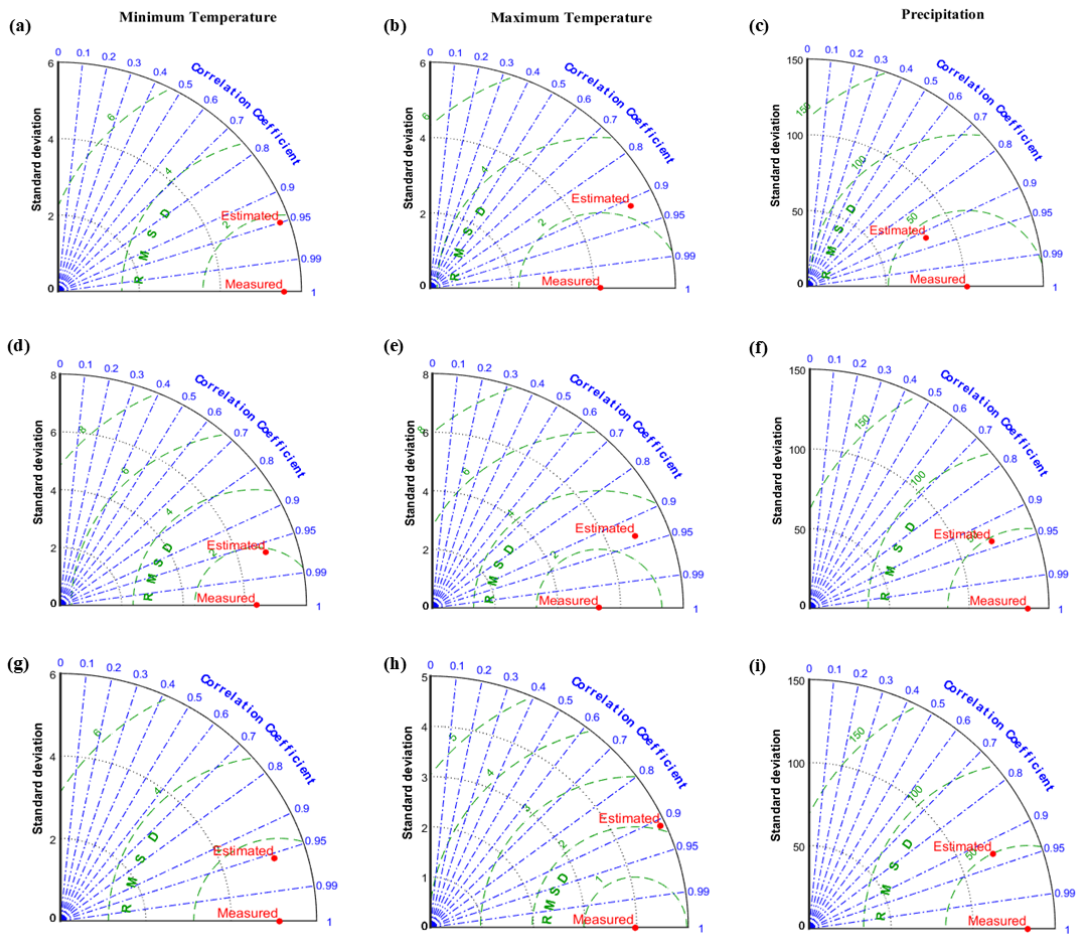
Figure 5. Taylor diagrams for all variables. ( a , d , g ) for Tmin; ( b , e , h ) for Tmax; ( c , f , i ) for Prcp. in each study area. Top row for AV; Middle row for BK; Bottom row for KSB.